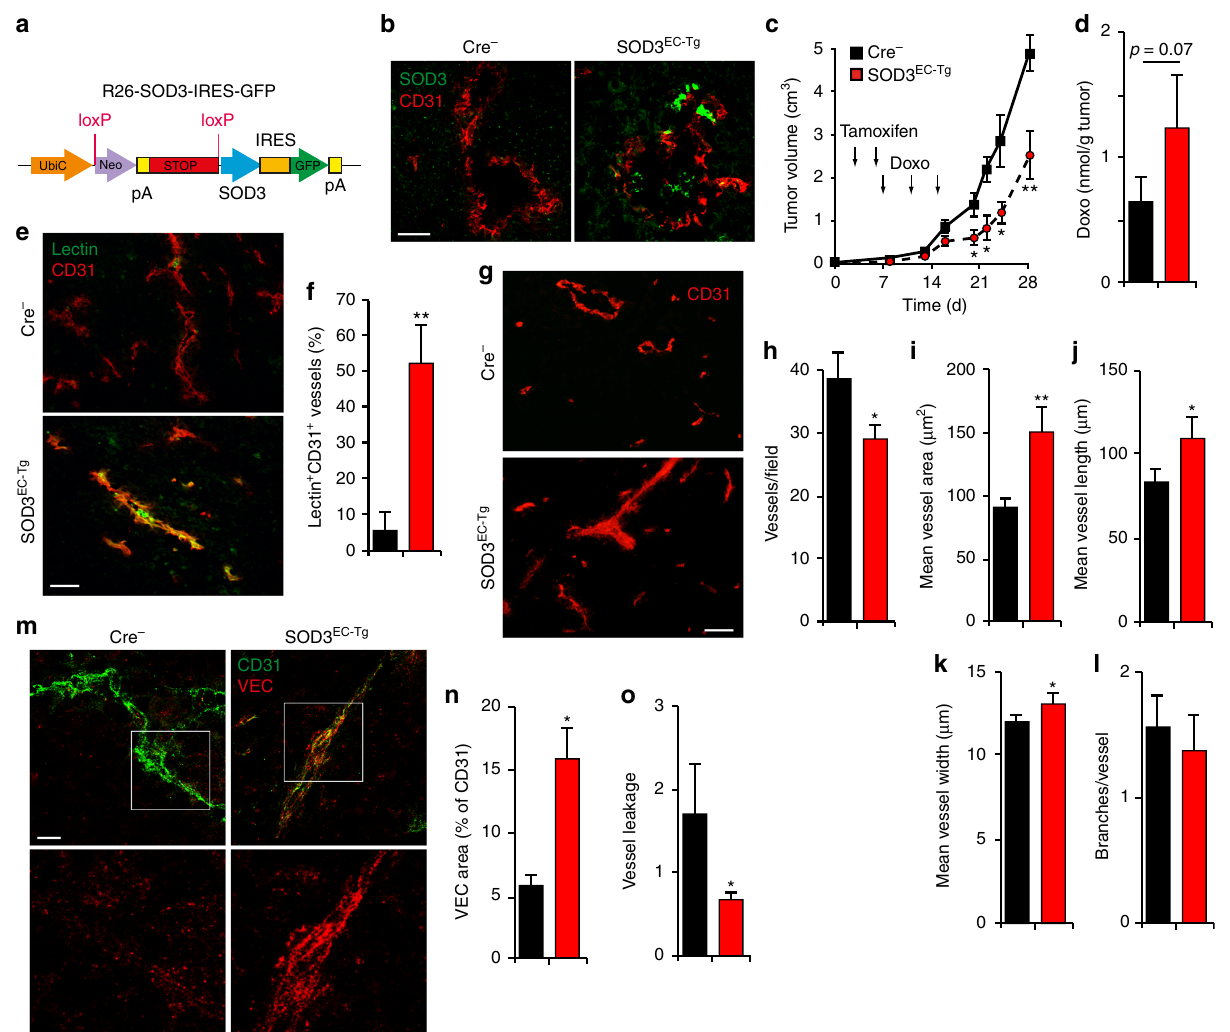
Fig. 3 EC-speci fi c SOD3 expression is suf fi cient to increase Doxo effect. a Conditional expression allele for the SOD3-IRES-GFP gene at the ROSA26 locus. b SOD3 (green) and CD31 (red) detection in sections from tumors grown in Cre-expressing and Cre − mice after tamoxifen induction. c LLC tumor growth kinetics in SOD3 EC-Tg and control (Cre − ) mice. Arrows indicate tamoxifen and Doxo treatments ( n = 10/group). d Doxo quanti fi cation in extracts of tumors dissected at day 16 from control and SOD3 EC-Tg mice ( n = 15 or 17 mice/group). e , f Images and quanti fi cation of lectin-FITC-perfused and CD31-stained vessels in control and SOD3 EC-Tg tumors (0.7 – 1.2 cm 3 ) dissected at day 20. g CD31 staining of control and SOD3 EC-Tg tumors at end point. h – l CD31 + structure density ( h ), mean area covered by CD31 + structures ( i ), mean vessel length ( j ) and diameter ( k ), and the number of vessel branches (l), determined in images as in g . m CD31 (green) and VEC (red) staining of tumors grafted in SOD3 EC-Tg and control mice. Bottom panels show red staining in a magni fi ed area. n Quanti fi cation of the VEC area in CD31 + structures from images as in m . o Vessel permeability determined by FITC-lectin and Texas Red-dextran in tumors dissected at day 17 from control and SOD3 EC-Tg mice. For b , e – o , 10 – 20 images were analyzed from 5 mice/group; * p < 0.05, ** p < 0.01, two-tailed Student ’ s t- test. Bar, 50 μ